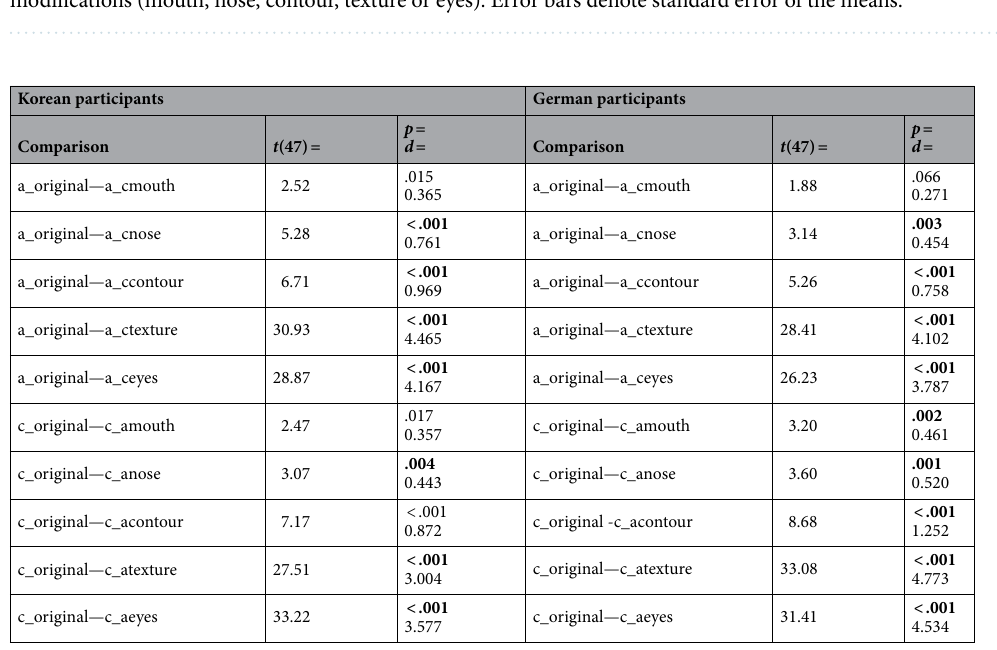
Figure 2. Ethnicity classification as percentage of parent race for faces without (original) or with featural modifications (mouth, nose, contour, texture or eyes). Error bars denote standard error of the means.